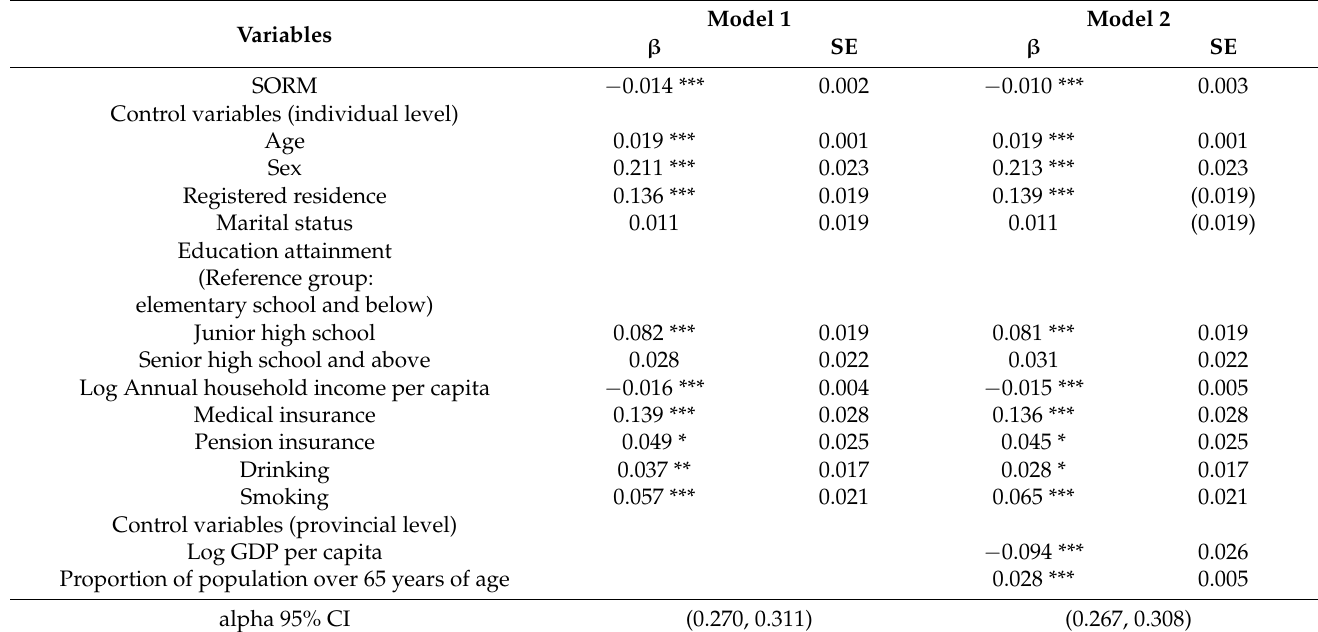
Table 5. Negative binomial regression analysis of the effects of SORM on NCDs (per capita).